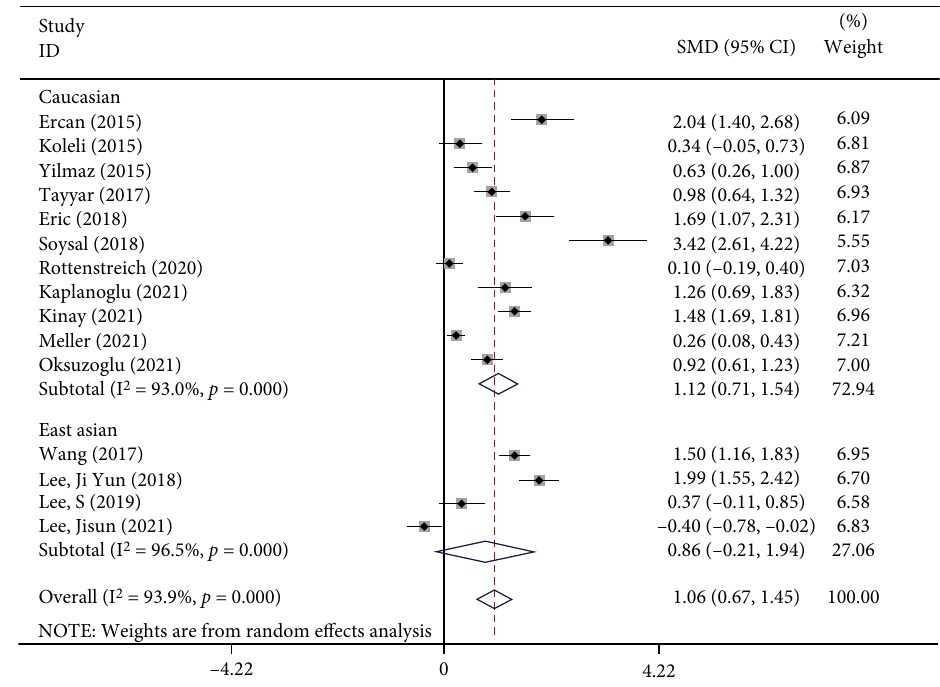
Figure 3: Subgroup analysis of di ff erences in NLR level between patients with AT compared to patients who were operated due to adnexal mass and reported as having a benign ovarian cyst, without torsion, according to